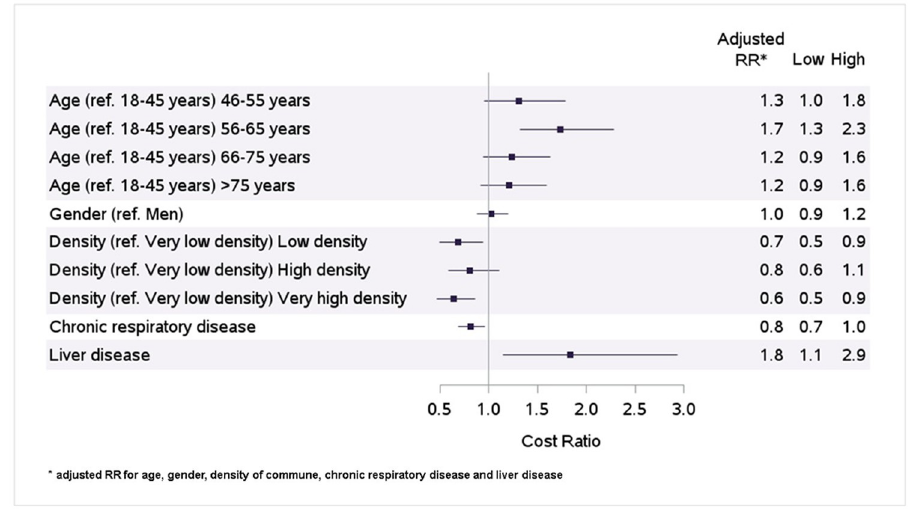
Fig 3. Factors associated with hospital cost of